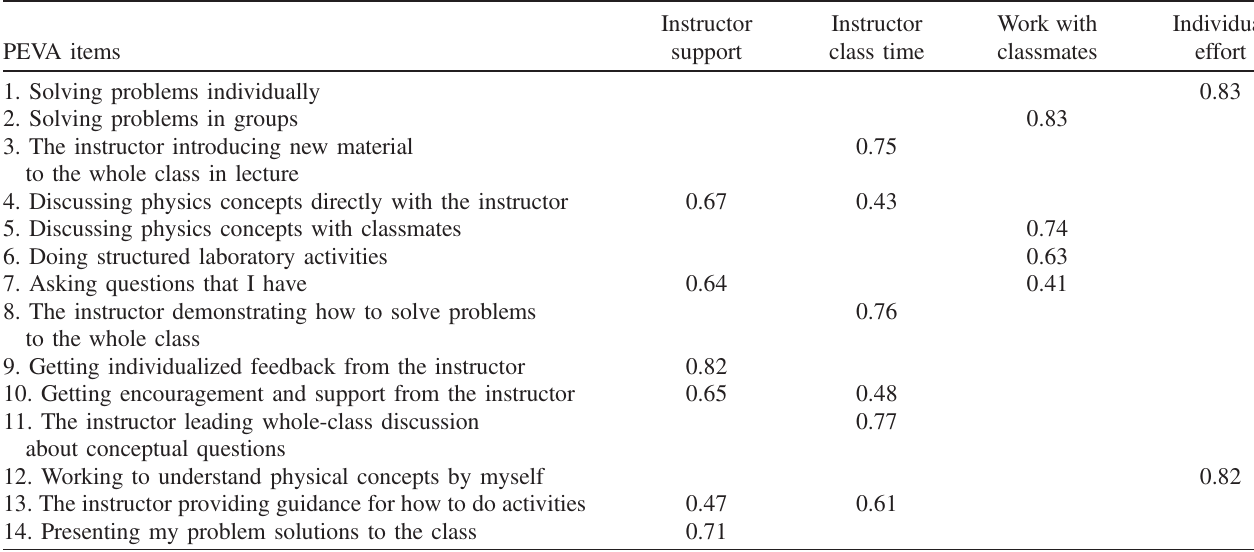
TABLE II. Items in the PEVA and loadings onto each of four theoretical components. PEVA items